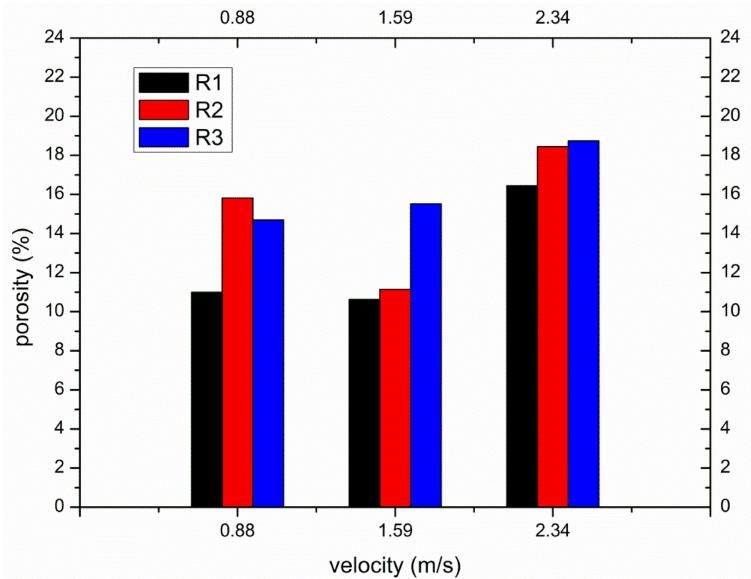
Figure 11. The porosity at different locations in the right window under different fast shot